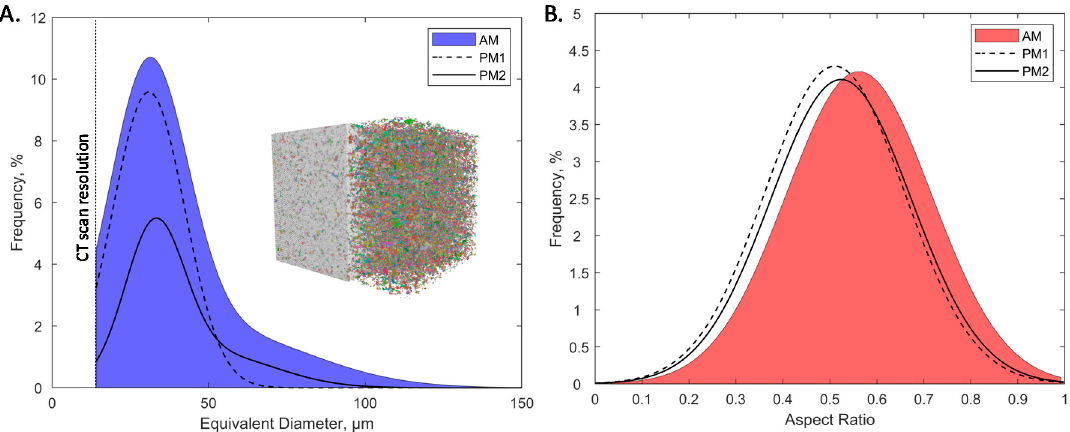
Figure 8. Porosity analysis: ( A ) equivalent diameter and ( B ) aspect ratio. Table 3. Summary of porosity analysis.